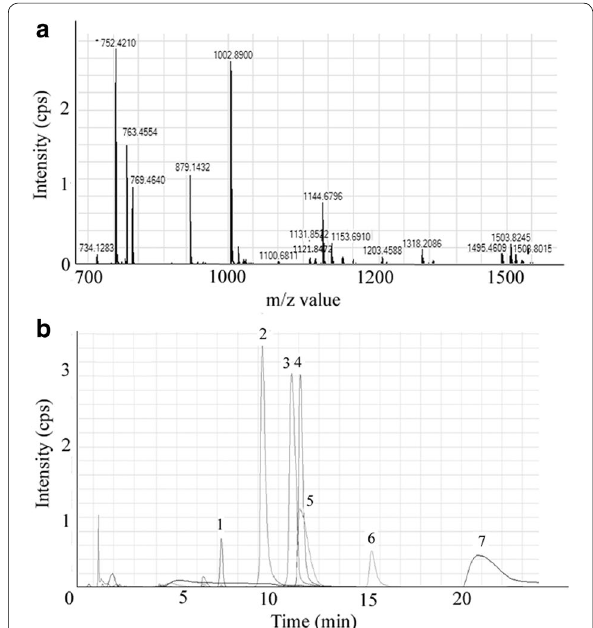
Fig. 1 QTOF MS spectrum and ion chromatograms of PSMs. a QTOF MS spectrum of PSMs in the mixed standard solution. b Extracted ion chromatograms of PSMs in USA 300 culture supernatant: 1, PSMβ2 (m/z 1495.4609); 2, PSMα3 (m/z 879.1432); 3, PSMα2 (m/z 769.4640); 4, PSMα1 (m/z 1144.6796); 5, δ-toxin (m/z 1503.8245); 6, PSMβ1 (m/z 1508.8015); 7, PSMα4 (m/z 734.1283)